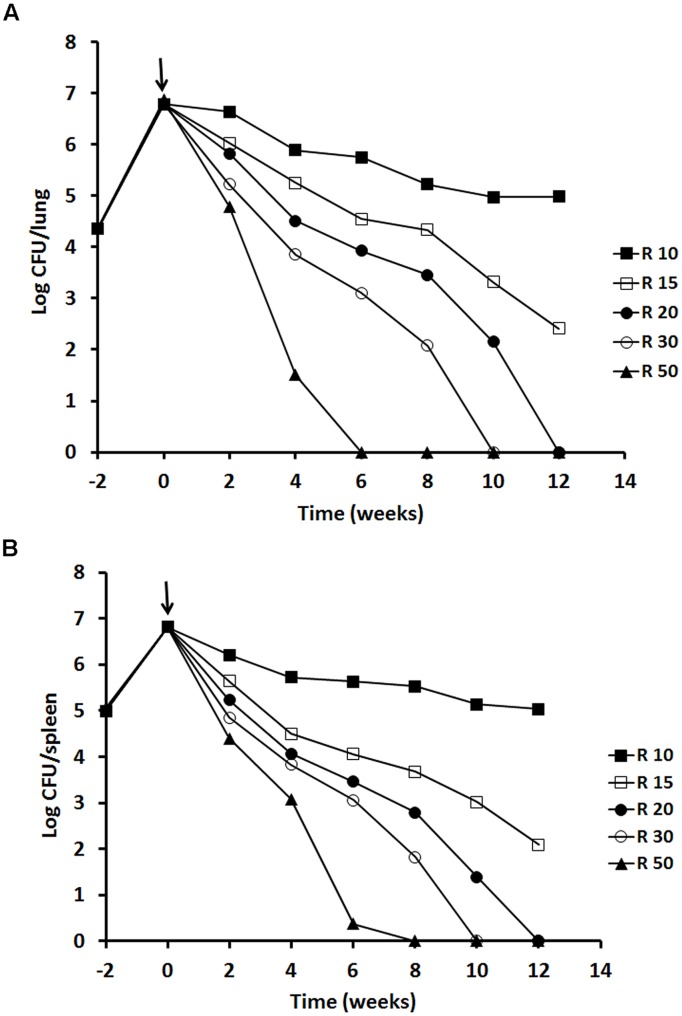
Viability of M. tuberculosis H37Rv in BALB/c mice after rifampicin treatment. The results of a single experiment are shown with viability expressed as log CFU counts per lung (A) and spleen (B). Mice were infected intravenously and the infection was allowed to progress for 2 weeks prior to treatment with rifampicin at 10, 15, 20, 30 and 50 mg/kg indicated as a solid arrow for 12 weeks (time weeks 0–12). At week 2, 4, 6, 8, and 12 of post-treatment, four mice from each group were sacrificed for CFU counting. Data of the mice containing rifampicin-resistant strains for the 10 mg/kg group was excluded. ANOVA analysis demonstrated that the decline of CFU counts after treatment with different concentrations of rifampicin was significant in lungs P < 0.02 and in spleens P < 0.04.